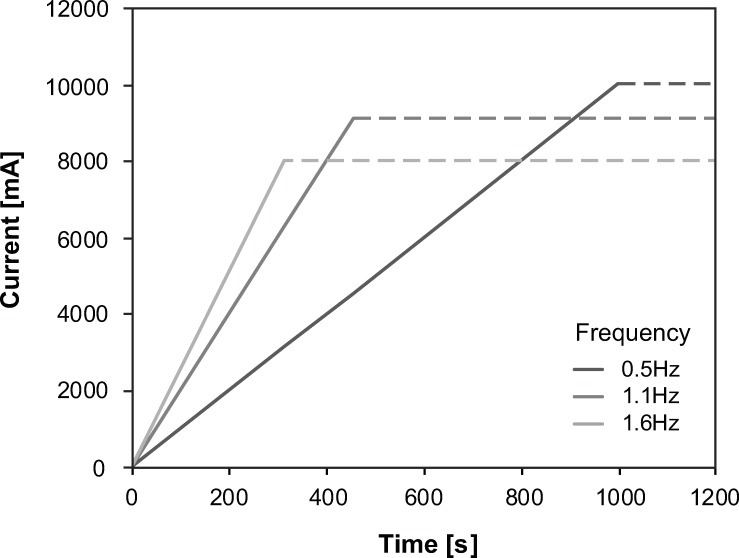
Accumulated current output per time across 500 stimuli for the three stimulation frequencies.The accumulated current was calculated based on mean absolute stimulation intensity (STIMINT) across all stimulation locations.